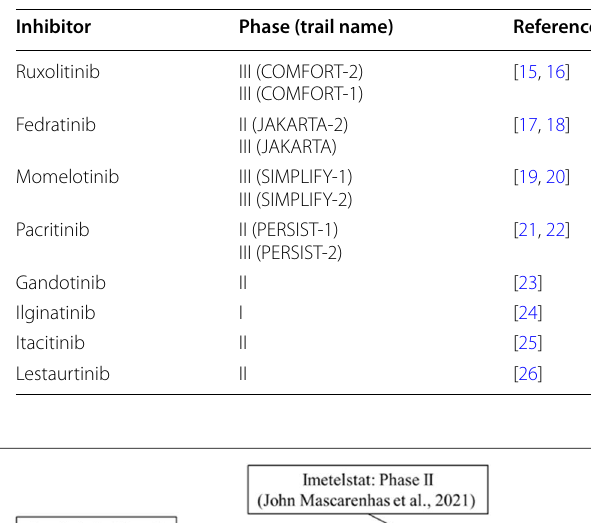
Table 1 Clinical trials of JAK inhibitors for